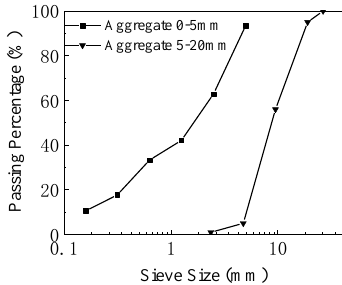
Figure 1. The fine and coarse aggregates: ( a ) The natural aggregate of 16–20 mm, ( b ) The recycled aggregate of 10–16 mm, ( c ) The recycled aggregate of 5–10 mm, and ( d ) The recycled aggregate of 0–5 mm.